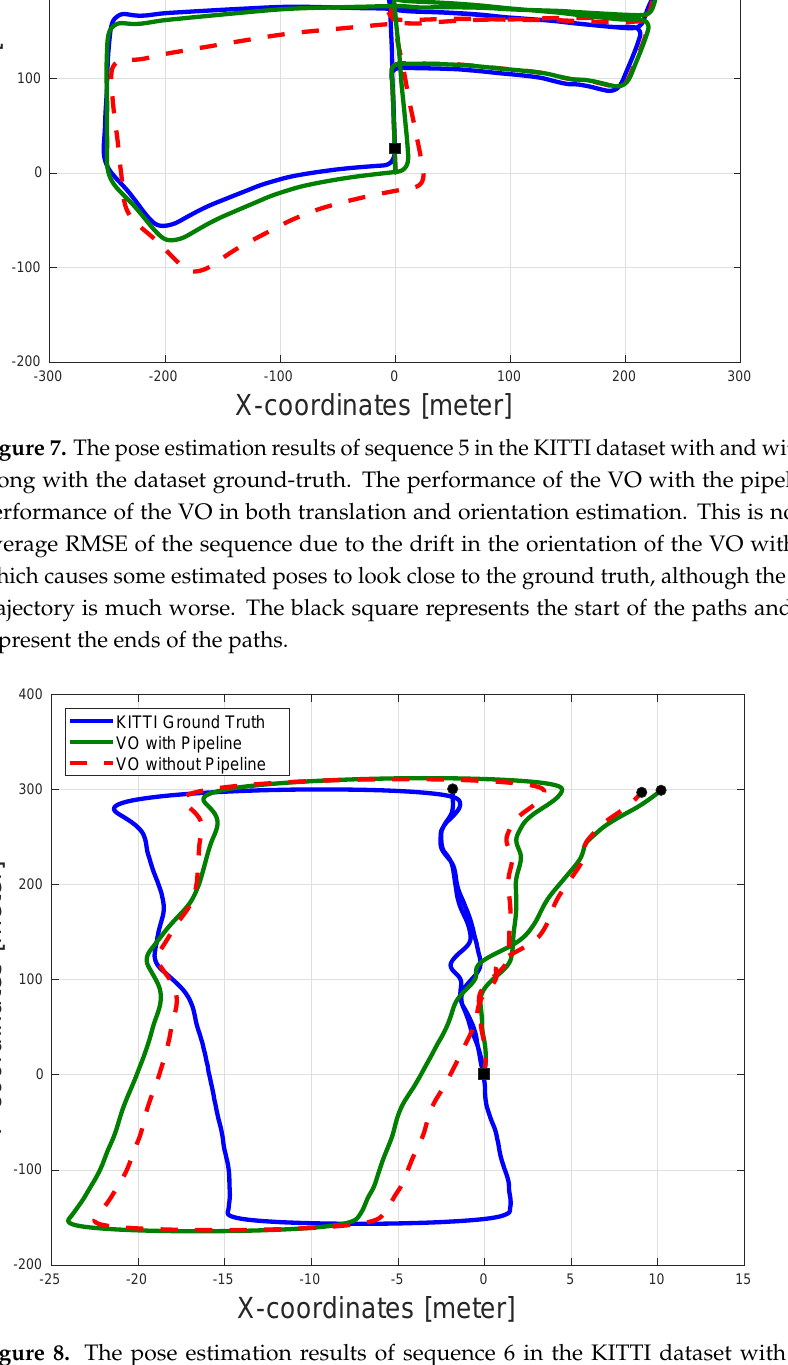
Figure 8. The pose estimation results of sequence 6 in the KITTI dataset with and without the pipeline along with the dataset ground-truth. The VO without the pipeline shows more accurate pose estimation compared to VO with the pipeline. However, the performance of both algorithms are very similar. The black square represents the start of the paths and the black circles represent the ends of the